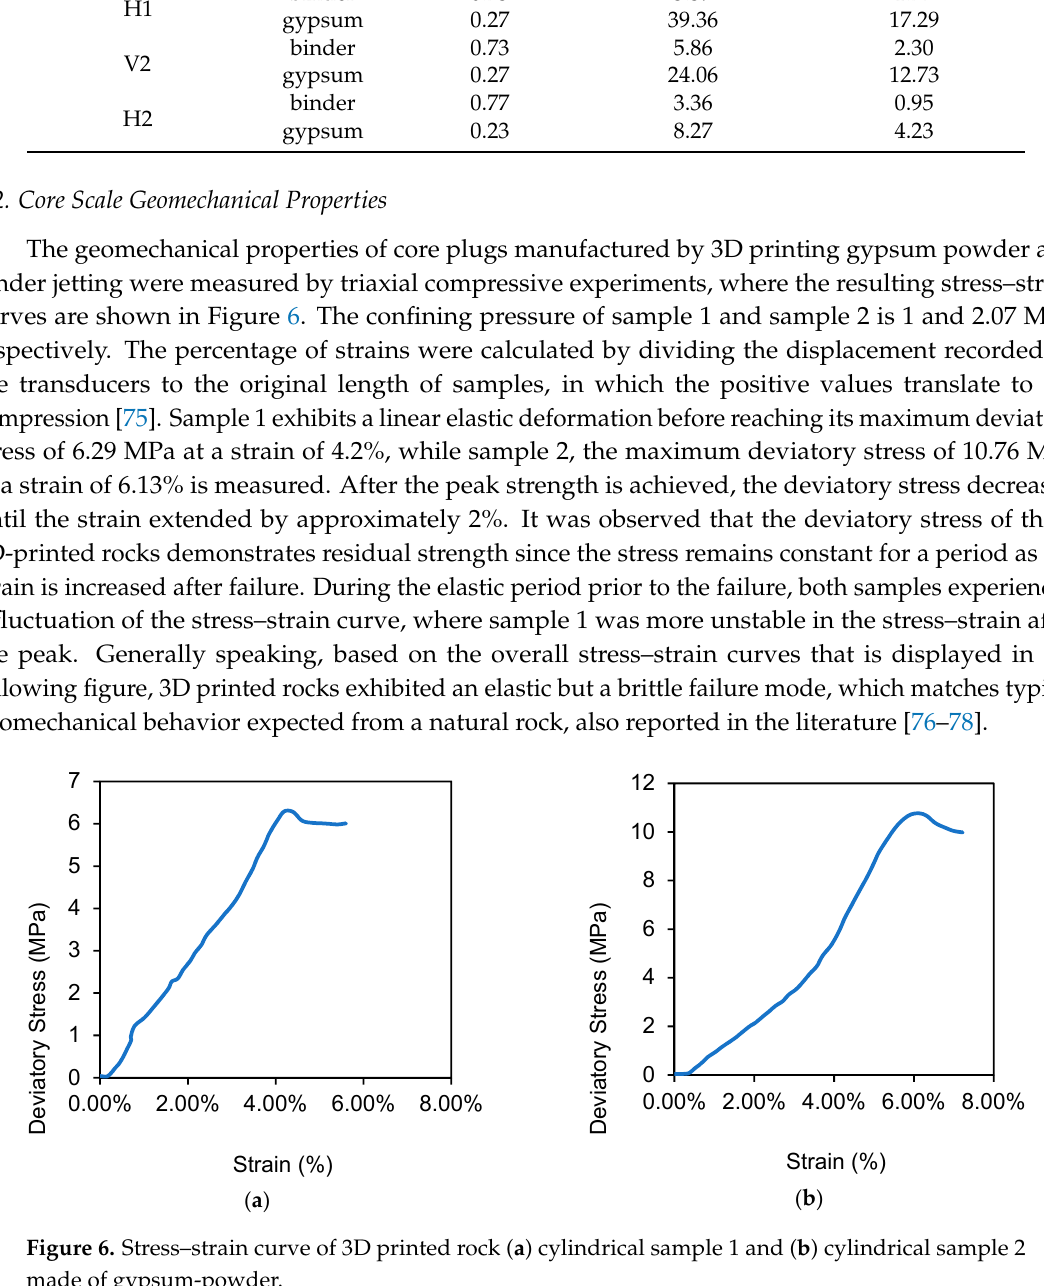
Figure 7. Failure envelope and Mohr’s circles of 3D printed rocks made up of gypsum powder. Cohesion (C) is 0.68 MPa and internal friction angle ( 𝜙 ) is 41°. 4. Validation and Comparison of Upscaling Methods Since Young’s modulus of the sample at the plug scale was also measured, and mechanical properties of every single constituent component was also obtained at microscale, it would be possible to use different upscaling methods to validate which theory yields a more accurate prediction of mechanical properties at macroscale from microscale ones. In order to do so, we programmed the codes of three different major upscaling methods and input the measurement results from nanoindentation, Young’s modulus and volume fraction of two phases to calculate plug scale modulus. In addition to inputting these properties, Poisson’s ratio of gypsum at crystal scale and binder should also be assumed, which, was input based on the values reported in the literature [58,81]. Poisson’s ratio of 0.33 and 0.3 for the gypsum and binder were considered, respectively. Furthermore, the pore space would play a critical role in mechanical behavior of any porous media including these 3D printed rocks. According to results in our past studies that were focused on pore structure characterization of gypsum powder 3D printed rocks at different sizes by different experimental methods [65], 33% porosity was used in the upscaling process to represent the voids in